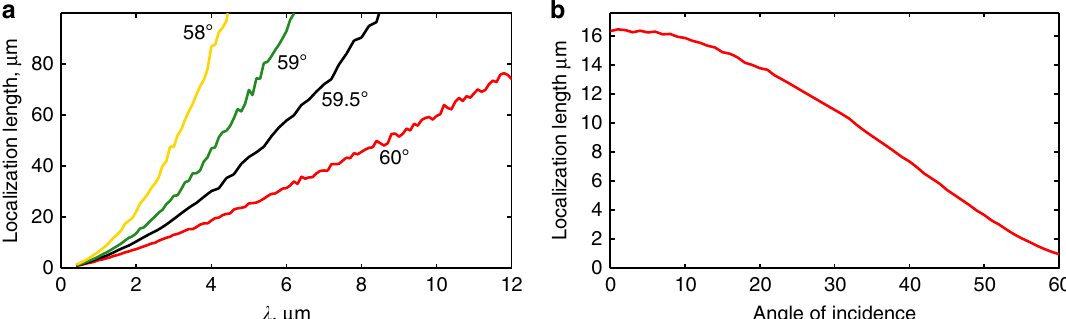
Figure 2 | Characteristics of localization by deep subwavelength disorder. ( a ) Localization length as a function of wavelength l for incidence at y c ¼ 60 (cid:2) and several other angles of incidence. As explained in the text, this plot is drawn for wavelengths, which are much larger than the layer thickness. ( b ) Localization length as a function of y , the angle of incidence for l ¼ 0.5 m m.